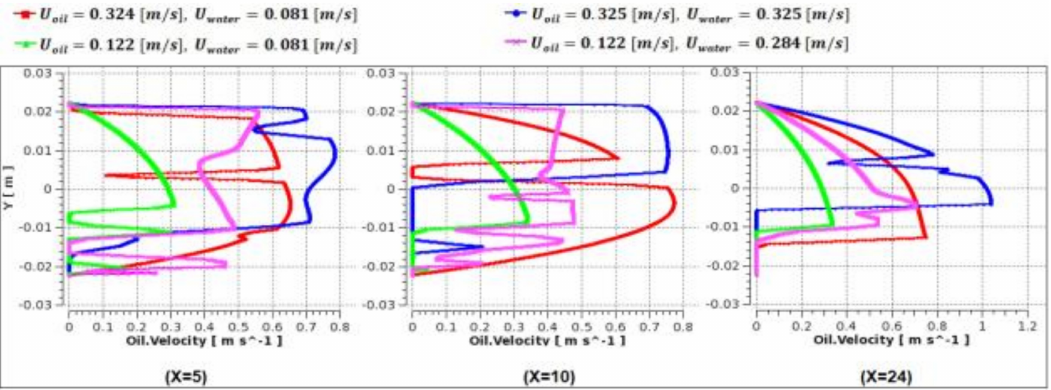
Figure 8. Course of the oil velocity along the vertical line in the Y direction at z = 0 and di ff erent dimensionless distances of x = L /